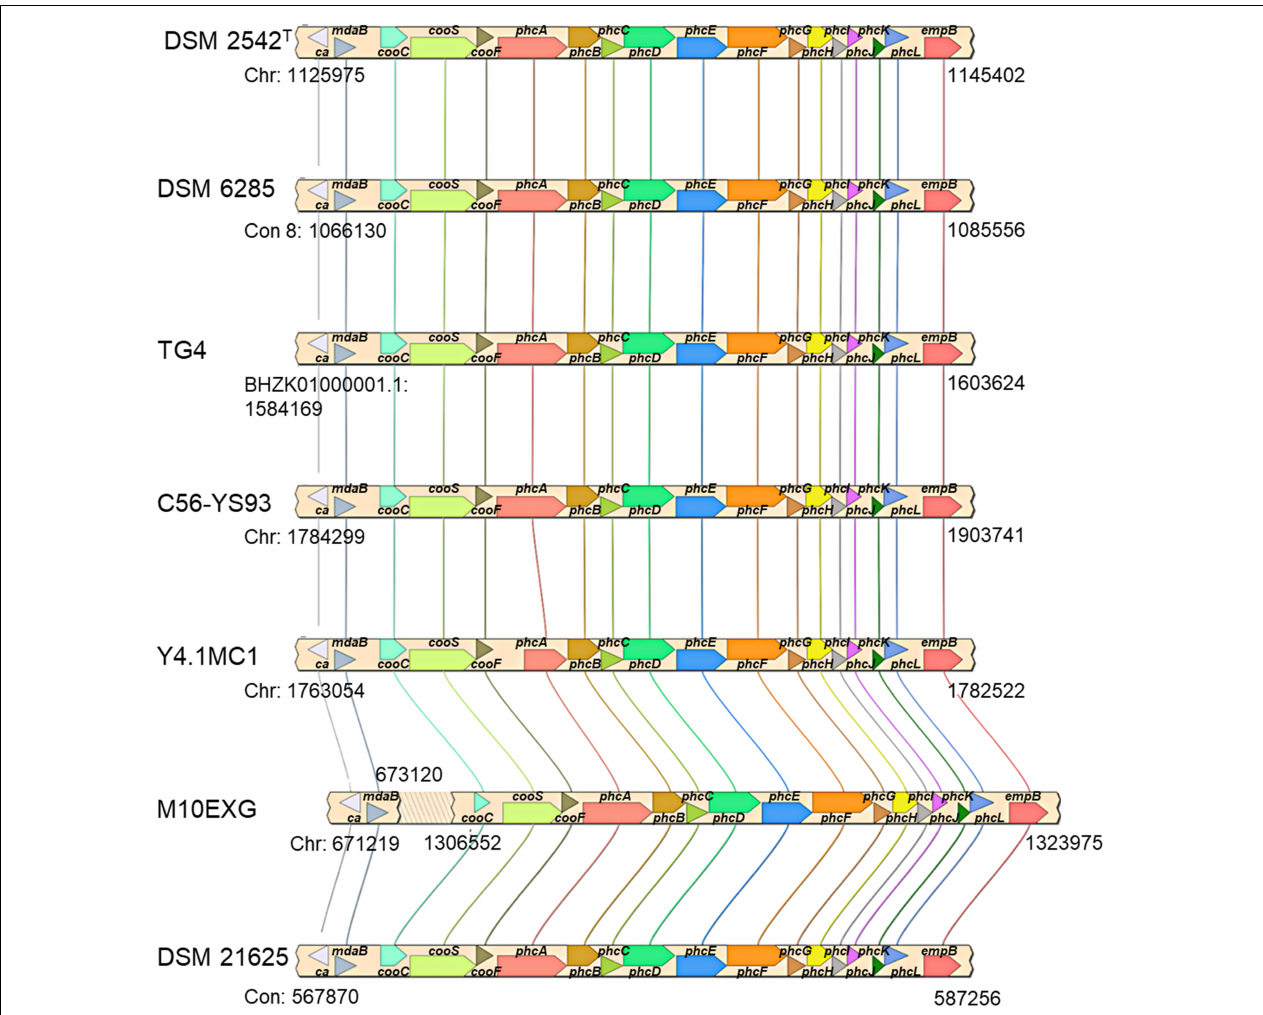
FIGURE 3 | cooCSF-phcA-L locus in seven P. thermoglucosidasius genomes visualized using SimpleSynteny. Only strains DSM 2542 T , DSM 6285 and TG4 have been shown to produce hydrogen via CO